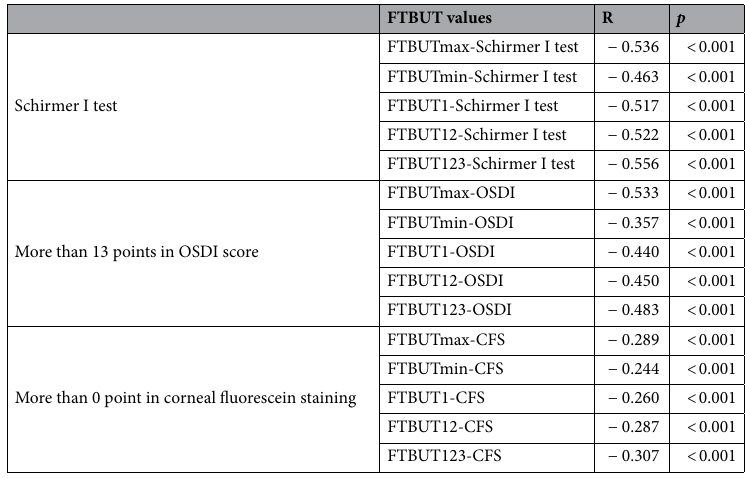
Table 4. Correlations between FTBUT values and other dry eye examinations.